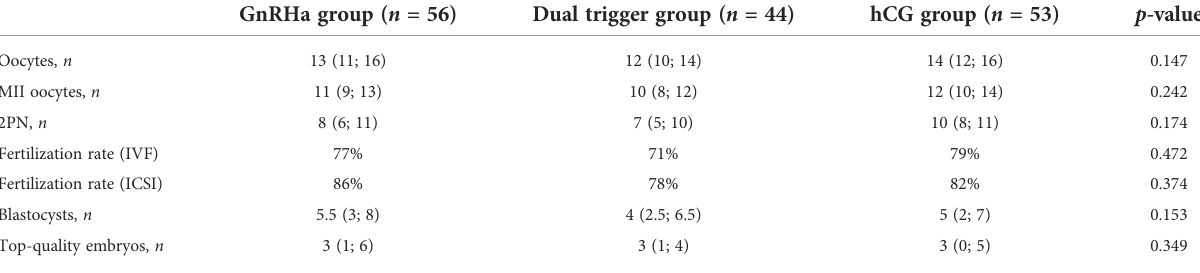
TABLE 7 Embryological outcome.